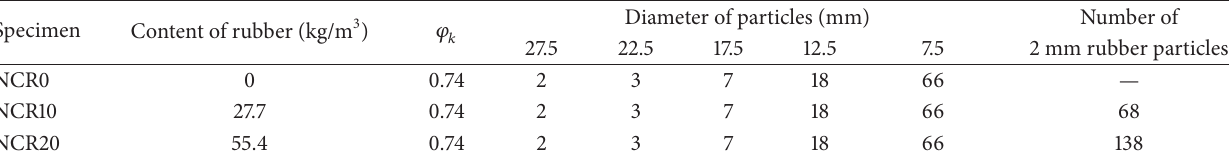
Table 2: Number of rubber particles under different rubber content.